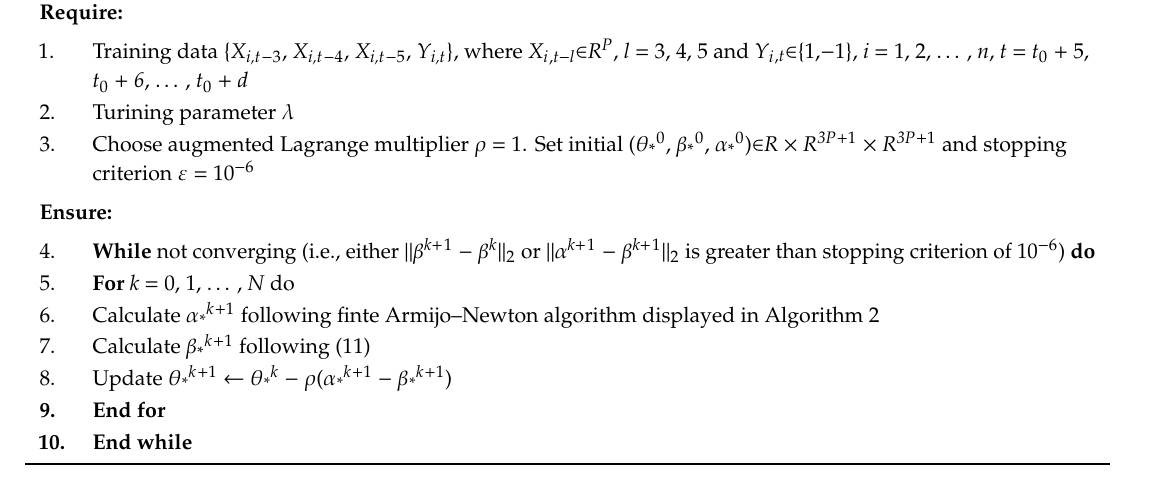
Algorithm 3. An ADMM algorithm framework for lasso–support vector machine (SVM) with lagged variables